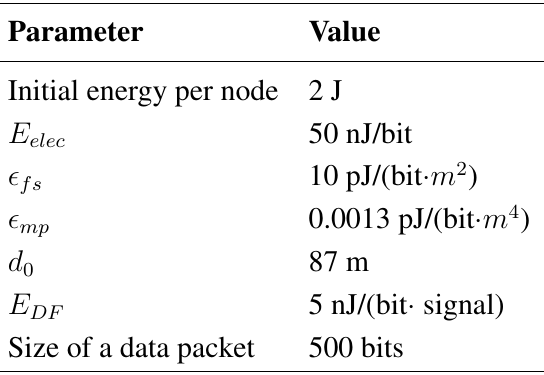
Table 1. Simulation parameters.